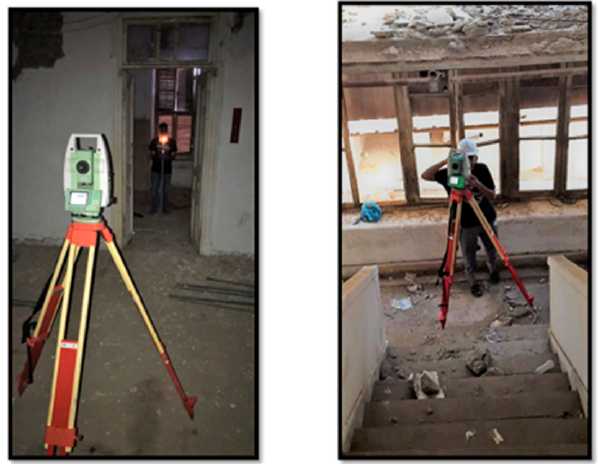
Figure 8. Using the backsight technique with the total station at the site. The next step was to identify the most suitable spots to place the black and white (B/W) targets for the TLS method (Figure 9). Moreover, to provide a 3D point cloud model with more accuracy and minimal errors, it was vital to provide at least three accurate B/W targets in common between these scan stations. The third step was to scan the Zainal House façades from the outside to the inside. In this step, the overlap between each scan was crucial to cover the whole area of Zainal House. Indeed, the overlapping between these scans was, on average, more than 70%. This could result in a high registration accuracy in case the cloud-to-cloud process was implemented. Each scan station’s resolution within a 10-m distance for indoor scanning was 0.07 m, and it was approximately 70 m for the outdoor scanning. The scanning process took about 2